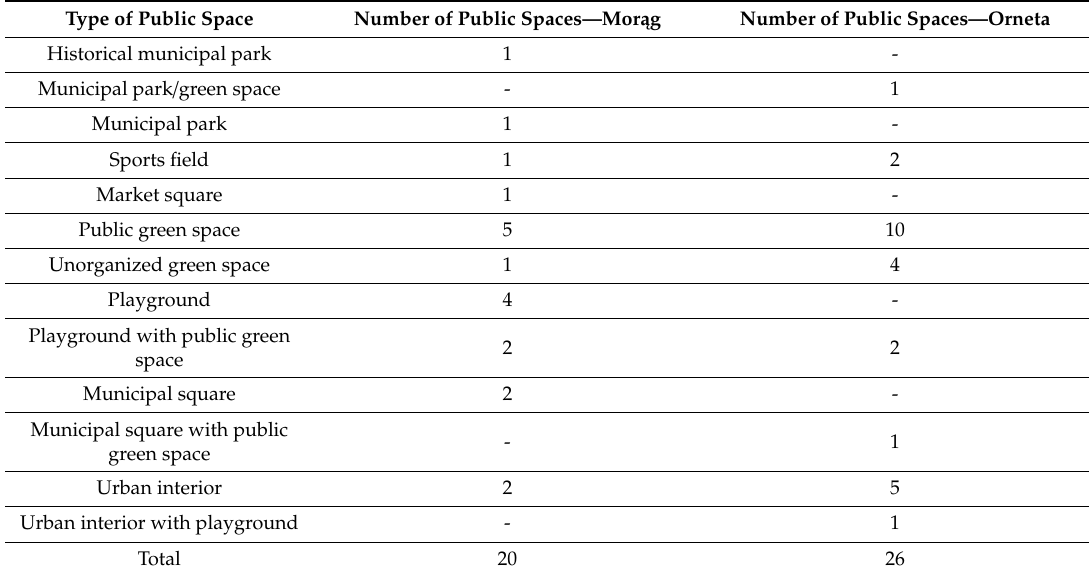
Table 2. List of public spaces inventoried in Mor ˛ag and Orneta. Source: own elaboration. Type of Public Space Number of Public Spaces—Mor